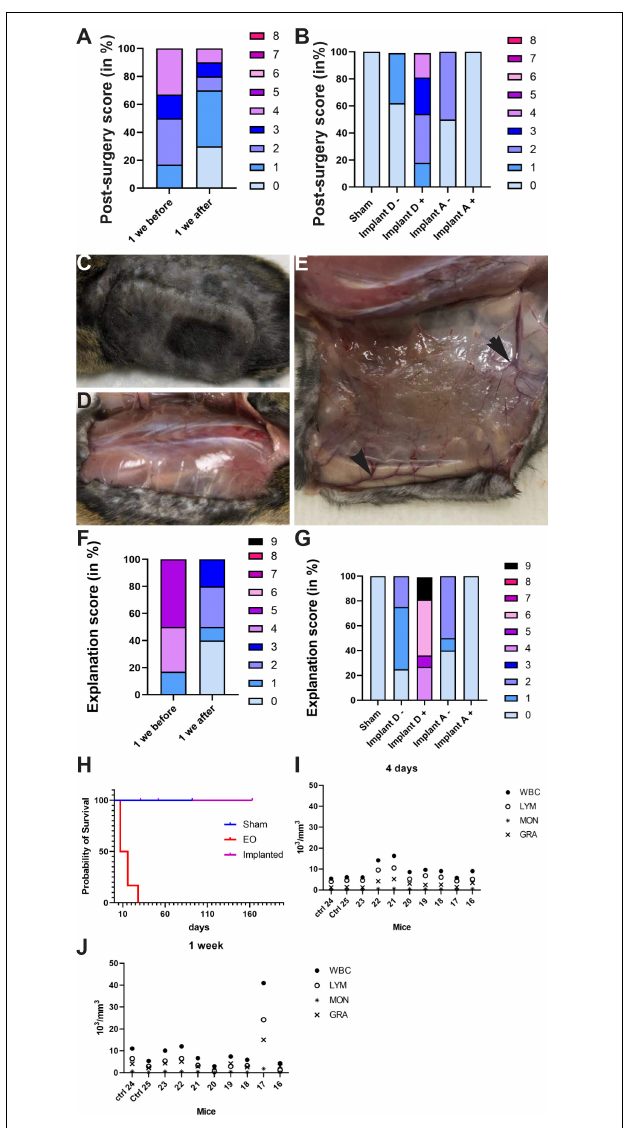
FIGURE 9 | (A,B) Histogram of post-surgery score in groups of mice: (A) mice directly implanted after sterilization (1 week before) or implanted at least 1 week after sterilization (1 week after) and (B) Sham, Implant D loaded or not with cells and Implant A loaded or not with cells. The post-surgery score was high (poor) in mice implanted with device EO and implant D loaded with cells vs. other groups. (C–E) Pictures taken during the device removal. No inflammation was observed on the tissue in contact with the device (C,D) . (E) Neovascularization observed on tissue in contact with the device. (F,G) Histogram showing explantation score in groups of mice: (F) directly implanted after sterilization (1 week before) or implanted at least 1 week after sterilization (1 week after) and (G) Sham, Implant D loaded or not with cells and Implant A loaded or not with cells. Explantation score was very high (poor) in mice with device EO and implant D loaded with cells vs. other groups. (H) Survival curves for sham and mice implanted directly after sterilization (EO) or at least 1 week after sterilization (Implanted). 50% of EO animals were sacrificed 7 days after implantation. (I,J) Hematology of blood sample in sham and implanted mice 4 days (I) and 1 week after implantation (J) . No infection was observed in implanted mice in the time exception of the mouse no. 17. WBC, white blood cell; LYM, lymphocytes; MON, monocytes; GRA,